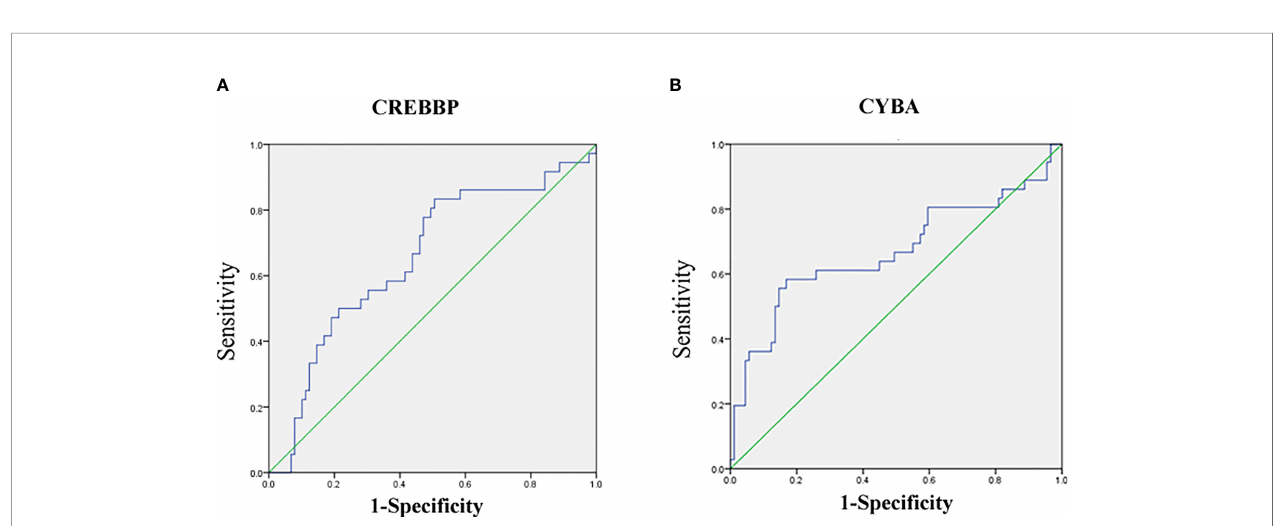
FIGURE 5 | Receiver-operating characteristic (ROC) curves for distinguishing SR and SS using urinary the sediment mRNA level of CREBBP or CYBA. (A) ROC of CREBBP; (B) ROC of